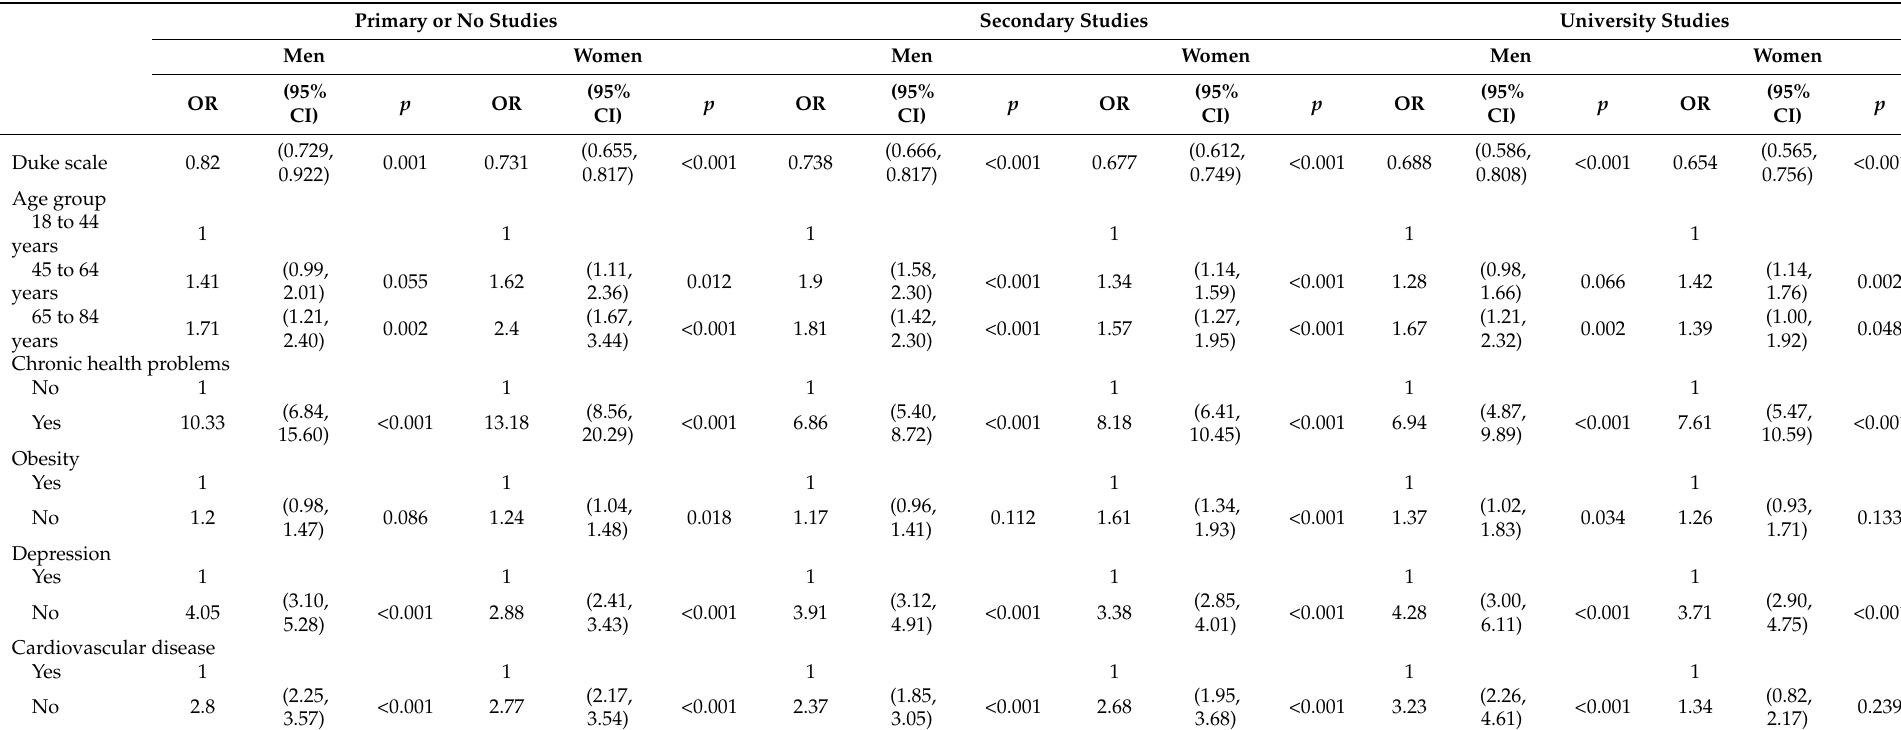
Table 4. Risk of presenting poor self-perceived health based on Duke functional social support scale by level of education and sex. Adult men and women. 2017 Spanish National Health Survey.